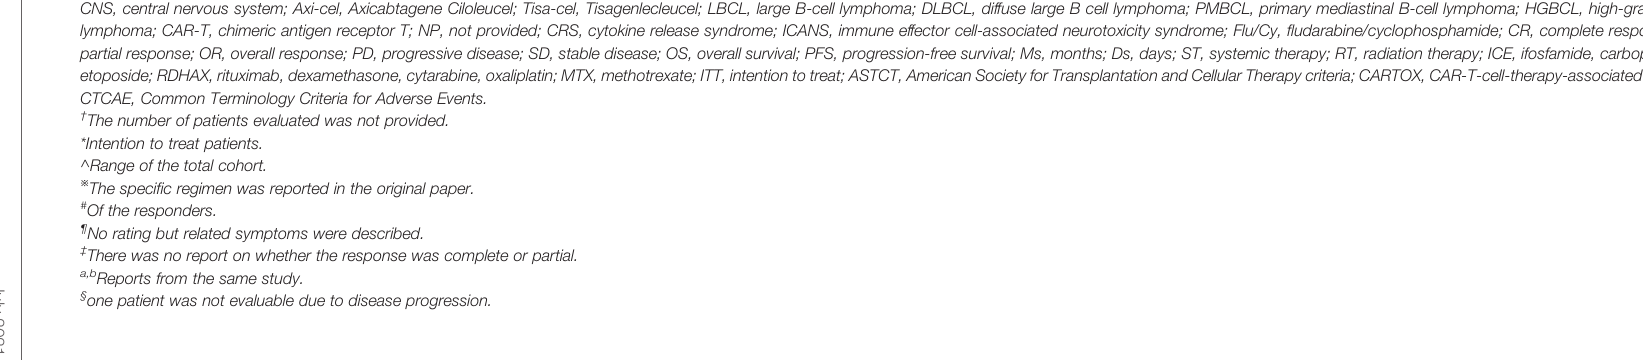
CTCAE, Common Terminology Criteria for Adverse Events. † The number of patients evaluated was not provided. *Intention to treat patients. ^Range of the total cohort. ※ The speci fi c regimen was reported in the original paper. # Of the responders. ¶ No rating but related symptoms were described. ‡ There was no report on whether the response was complete or partial. a,b Reports from the same study. § one patient was not evaluable due to disease